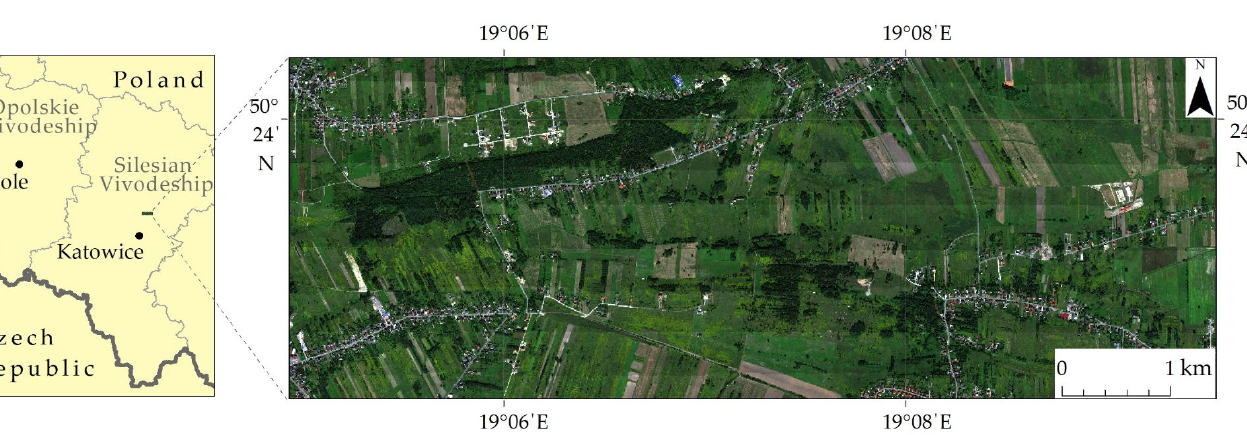
Figure 1. Research schema. Optimization of classification parameters and different scenarios of datasets and classifiers were published in Sabat-Tomala et al. [32]. The colors in the diagram refer to the following sections of the article: Section 2.2 Airborne hyperspectral HySpex images, Section 2.3 Field measurements, Section 2.4 Classification process, Section 2.5 Post-classification image analysis and Section 2.6 Map creation.